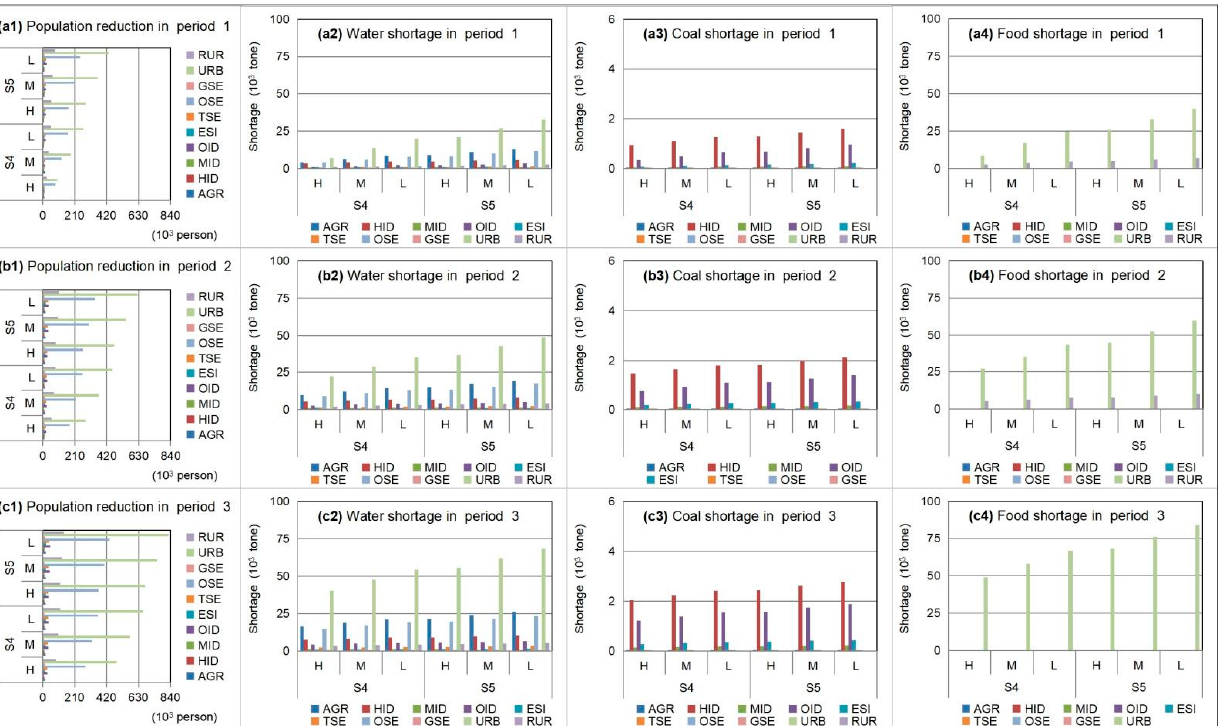
Figure 6. The satisfactions of water–food–energy target and corresponding population adjustments under S4 to S5 when α = 0.99 and β = 0.6 (agricultural sector denoted as “Ag”, industrial sector denoted as “In”, service sector denoted as “Se”, municipal sector denoted as “Mu”; heavy-consumption industry plant denoted as “HID”, medium-consumption industry plant denoted as “MID”, other industry plant denoted as “OID”, energy-supply industry plant denoted as “ESI”, traditional service industry plant denoted as “TSE”, other service industry plant denoted as “OSE”, environmental protection industry plant denoted as “GSE”, urban municipal consumption plant denoted as “URB”, rural consumption plant denoted as “RUR”; high level of resource availability denoted as “H”, medium level of resource availability denoted as “M”, low level of resource availability denoted as “L”) (( a1 – a4 ) are population adjustment and corresponding WEF shortages under S4 and S5 in period 1; ( b1 – b4 ) are population adjustment and corresponding WEF shortages under S4 and S5 in period 2; ( c1 – c4 ) are population adjustment and corresponding WEF shortages under S4 and S5 in period 3)